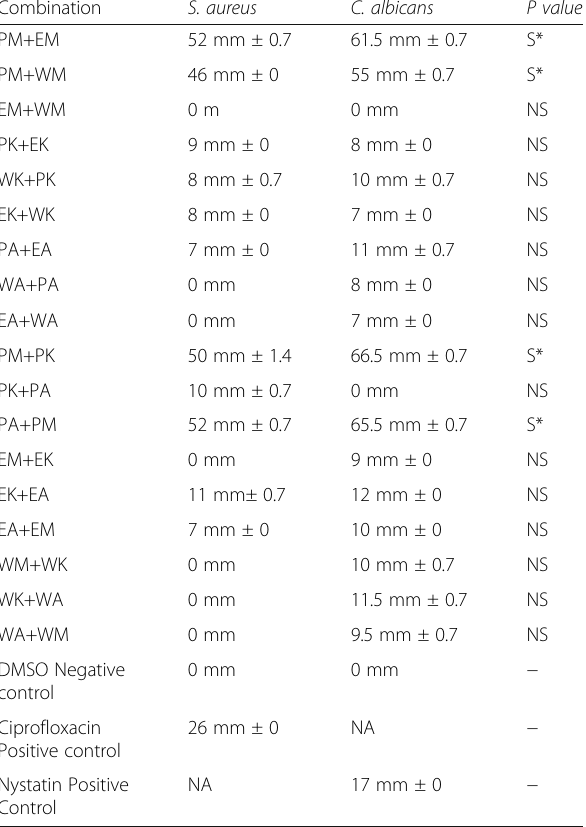
Table 2 Mean zone of inhibition produced by herbal extract when used in combinations against S. aureus and C. albicans Combination